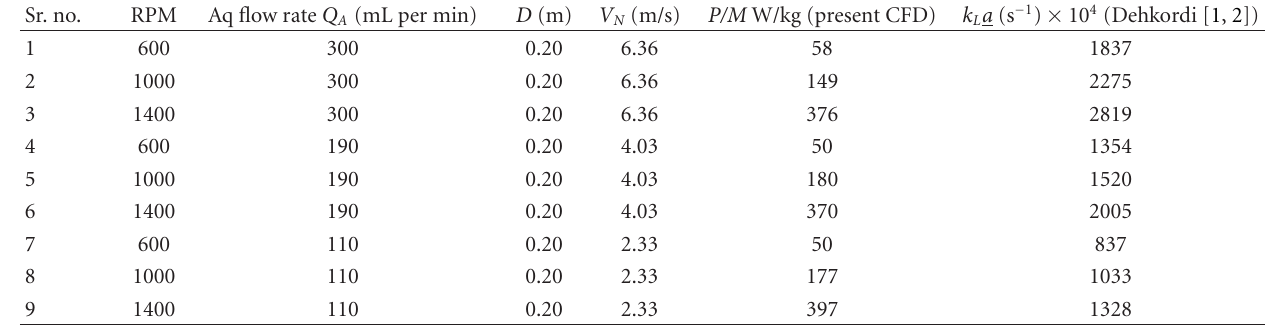
Table 2: Power consumption per unit mass from CFD and experimental k L a [1, 2]. Sr. no.